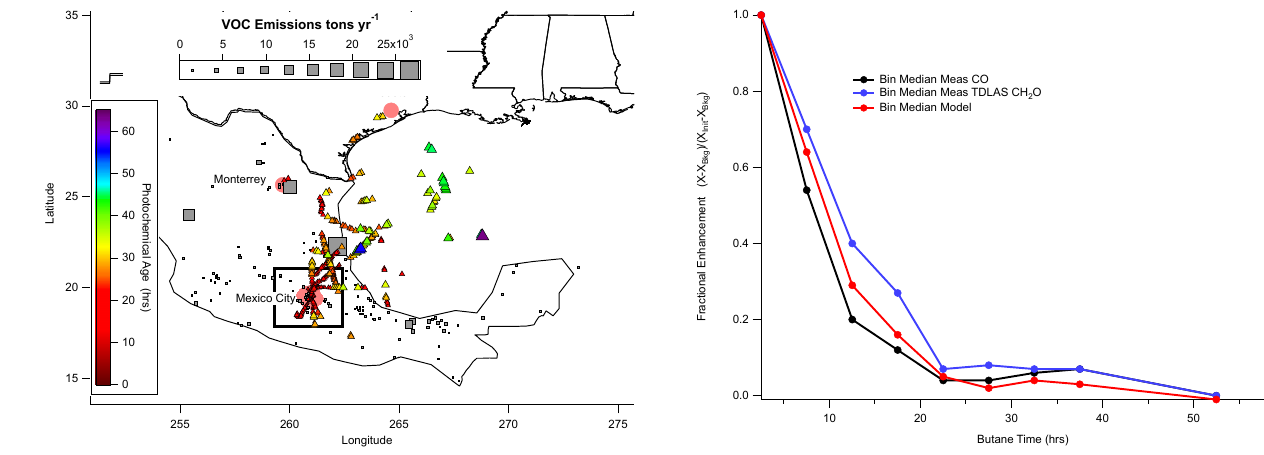
Fig. 12. Mexico City outflow events (1-min merged time base) based upon criteria discussed in text colored and sized by photo- chemical age from the ratio of 2-butyl nitrate to butane (Bertman et al., 1995; Perring et al., 2010). As in Fig. 9, the solid gray squares show VOC point sources sized by their emission values in tonsyr − 1 . The black square denotes the approximate limit for the region we define as the Mexico City area.